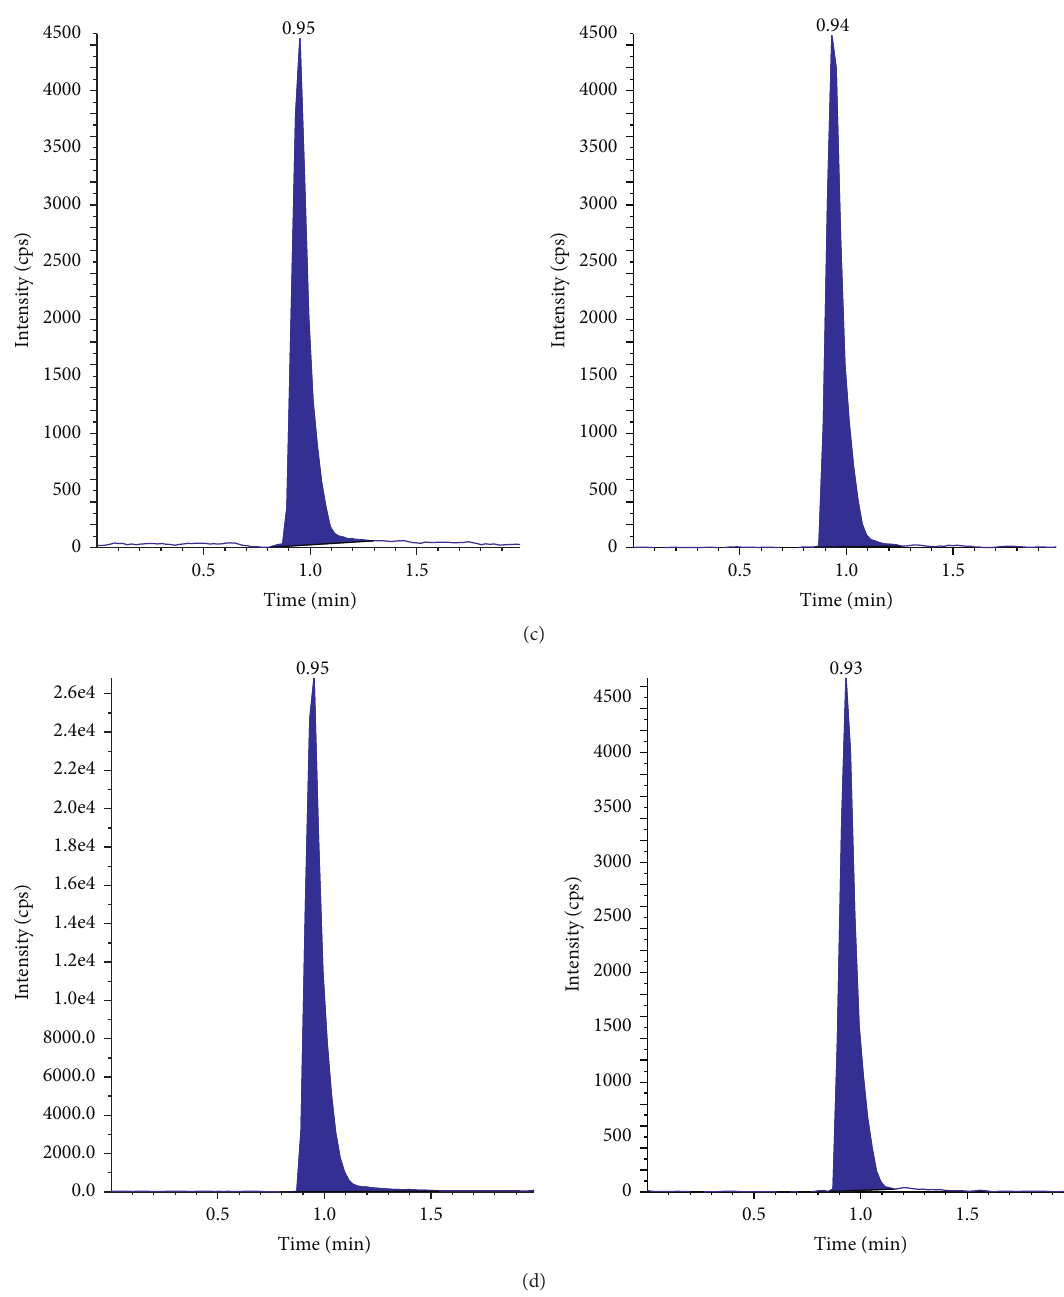
Figure 2: The chromatograms of TGC and IS in human plasma. Left is TGC, and right is IS. (a) Double-blank plasma sample; (b) blank plasma sample; (c) lower limit of quantification (LLOQ) plasma samples; and (d) a patient’s plasma sample. Table 1: The precision and accuracy of the determination of TGC in human plasma ( n � 6). Nominal